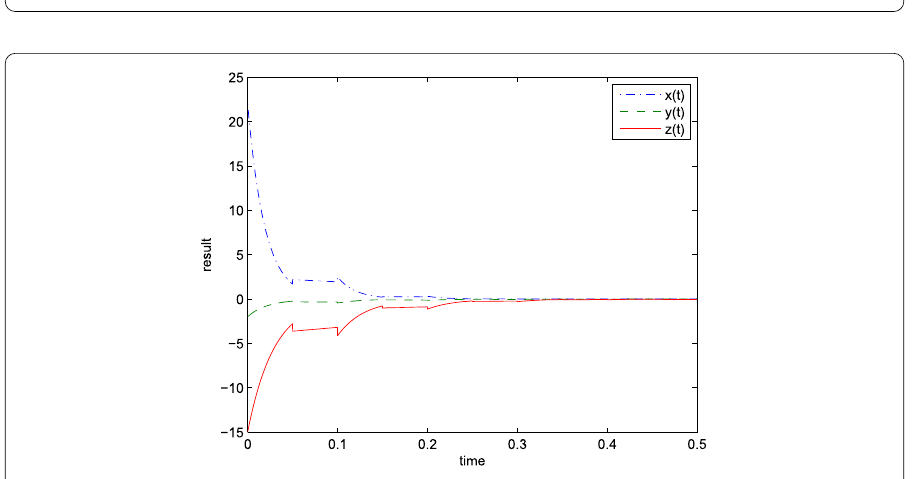
Figure 2 Time response curves of (3.1) via an alternate control system with double